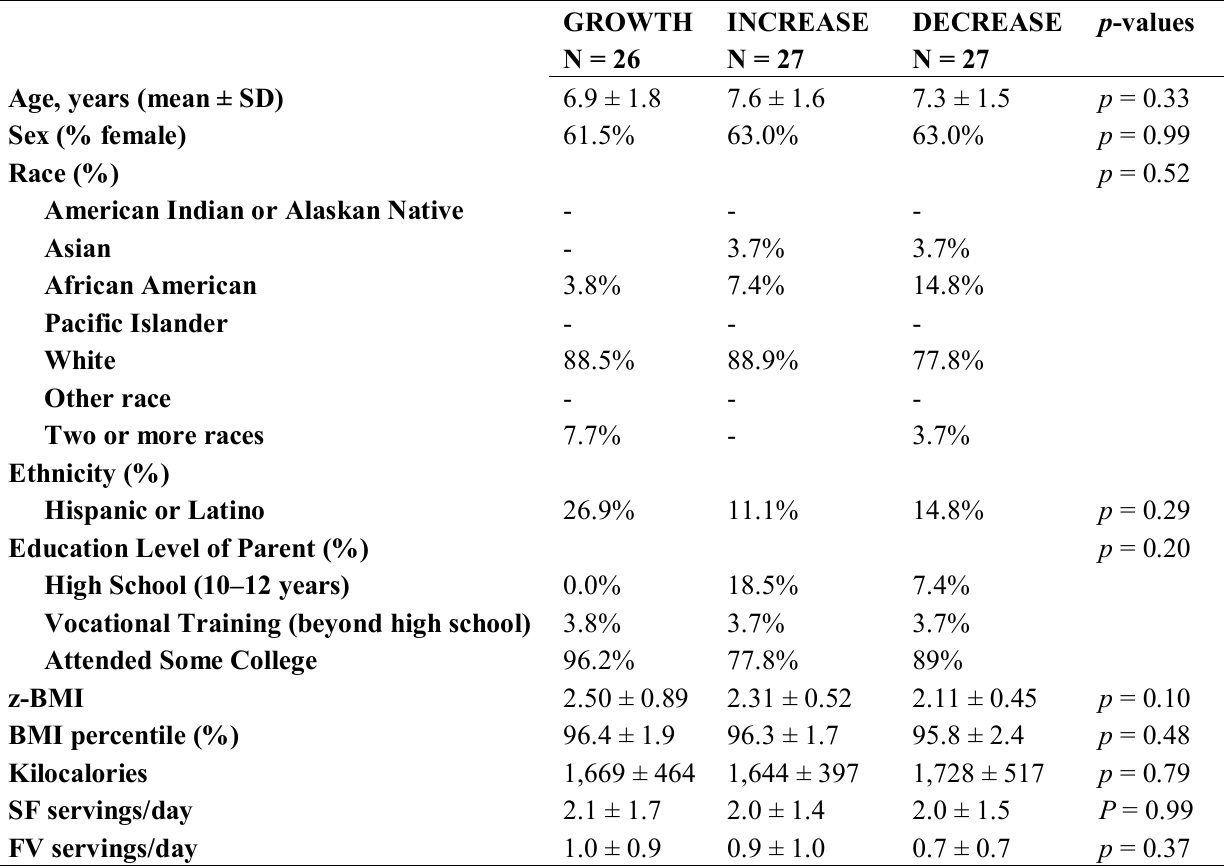
Table 1. Baseline characteristics of children by treatment condition. (N =